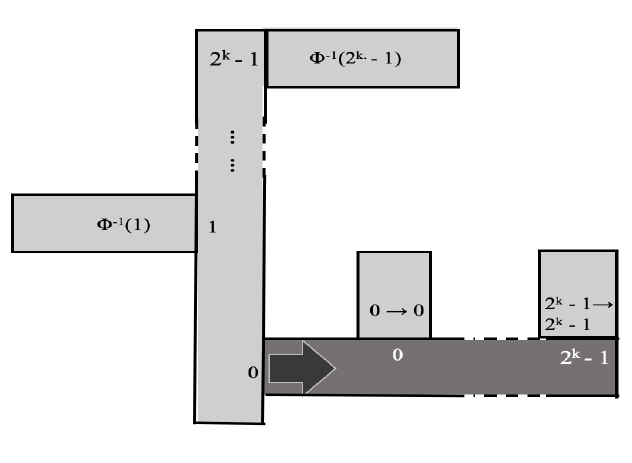
Figure 4. The two-dimensional ( L = 2) analysis represents turning a corner. We are lead into a hallway that distributes the search space Φ − 1 ( 0 ) into smaller batches.